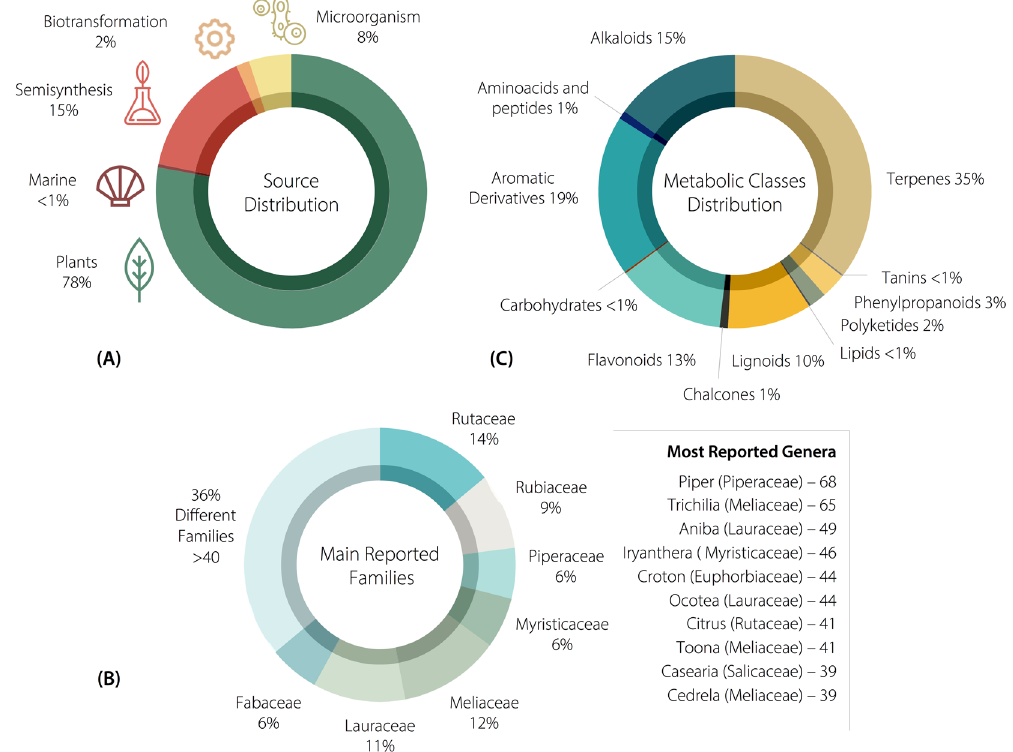
Figure 2. Statistics for the natural compounds from Brazilian biodiversity available in the NuBBE DB . ( A ) Sources of compounds. ( B ) The families from which the most compounds were identified, and the ten most prevalent genera. ( C ) Distribution of compounds by metabolic